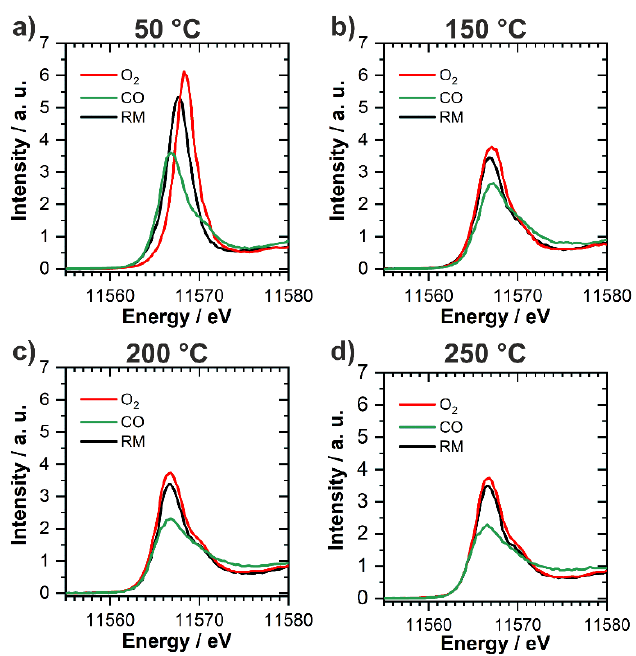
Figure 4. ( a – d ) Evolution with temperature of HERFD-XANES spectra of Pt singles sites on CeO 2 under different gas atmospheres, as collected at the middle position of the catalyst bed (red curves: 10% O 2 /He, green curves: 1000 ppm CO/He and black curves: reaction mixture with 1000 ppm CO, 10% O 2 in He).